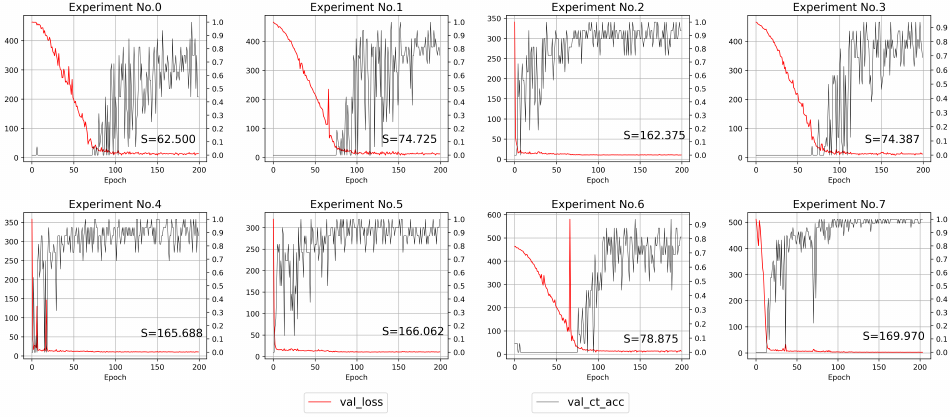
Figure 12. Ablation study of loss and CT ACC on the validation set during model training, where S denotes the area enclosed by the curve val_ct_acc and the X-axis.